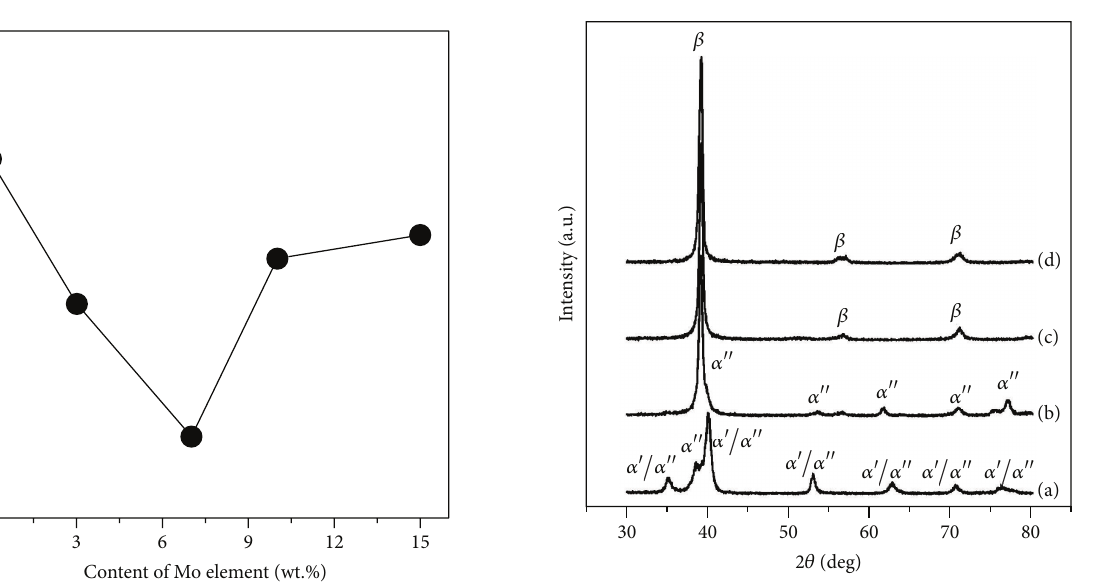
Figure 2: Elastic moduli of the Ti-xMo alloys.